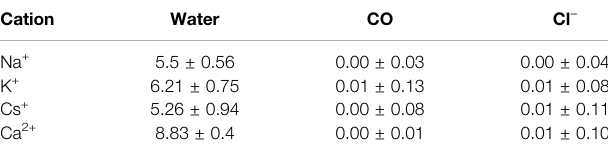
TABLE 1 | Average number (and standard deviation) of contacts between water, oxygens from CO, and Cl − anions participating in the fi rst coordination sphere of each cation. The radius of the fi rst coordination sphere was taken from the RDF calculations. Just the last 180 ns were considered for the